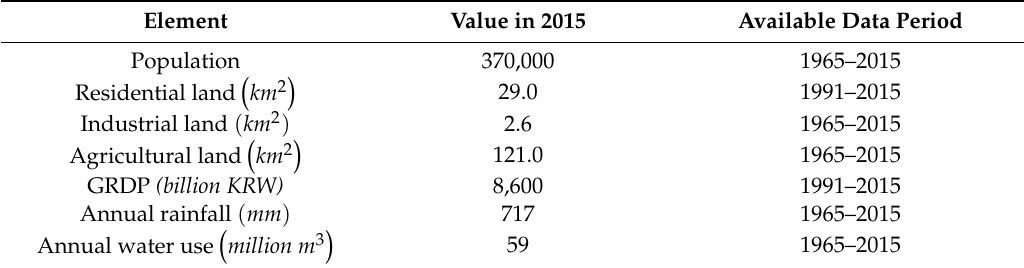
Table 2. Statistics of the study